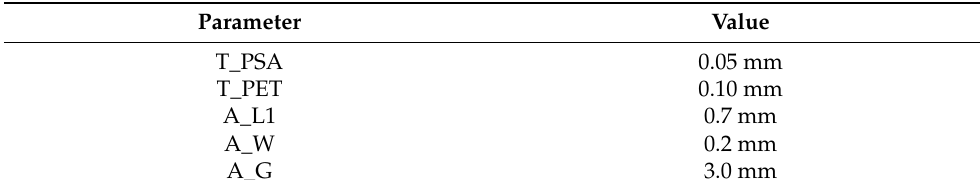
Table 2. The physical dimensions of the antenna combined with the